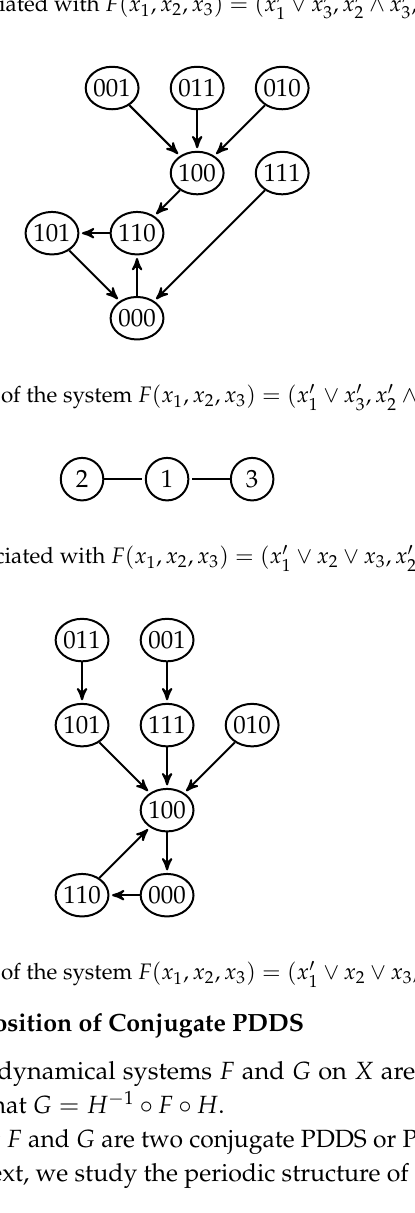
Figure 9. Graph associated with F ( x 1 , x 2 , x 3 ) = ( x (cid:48)